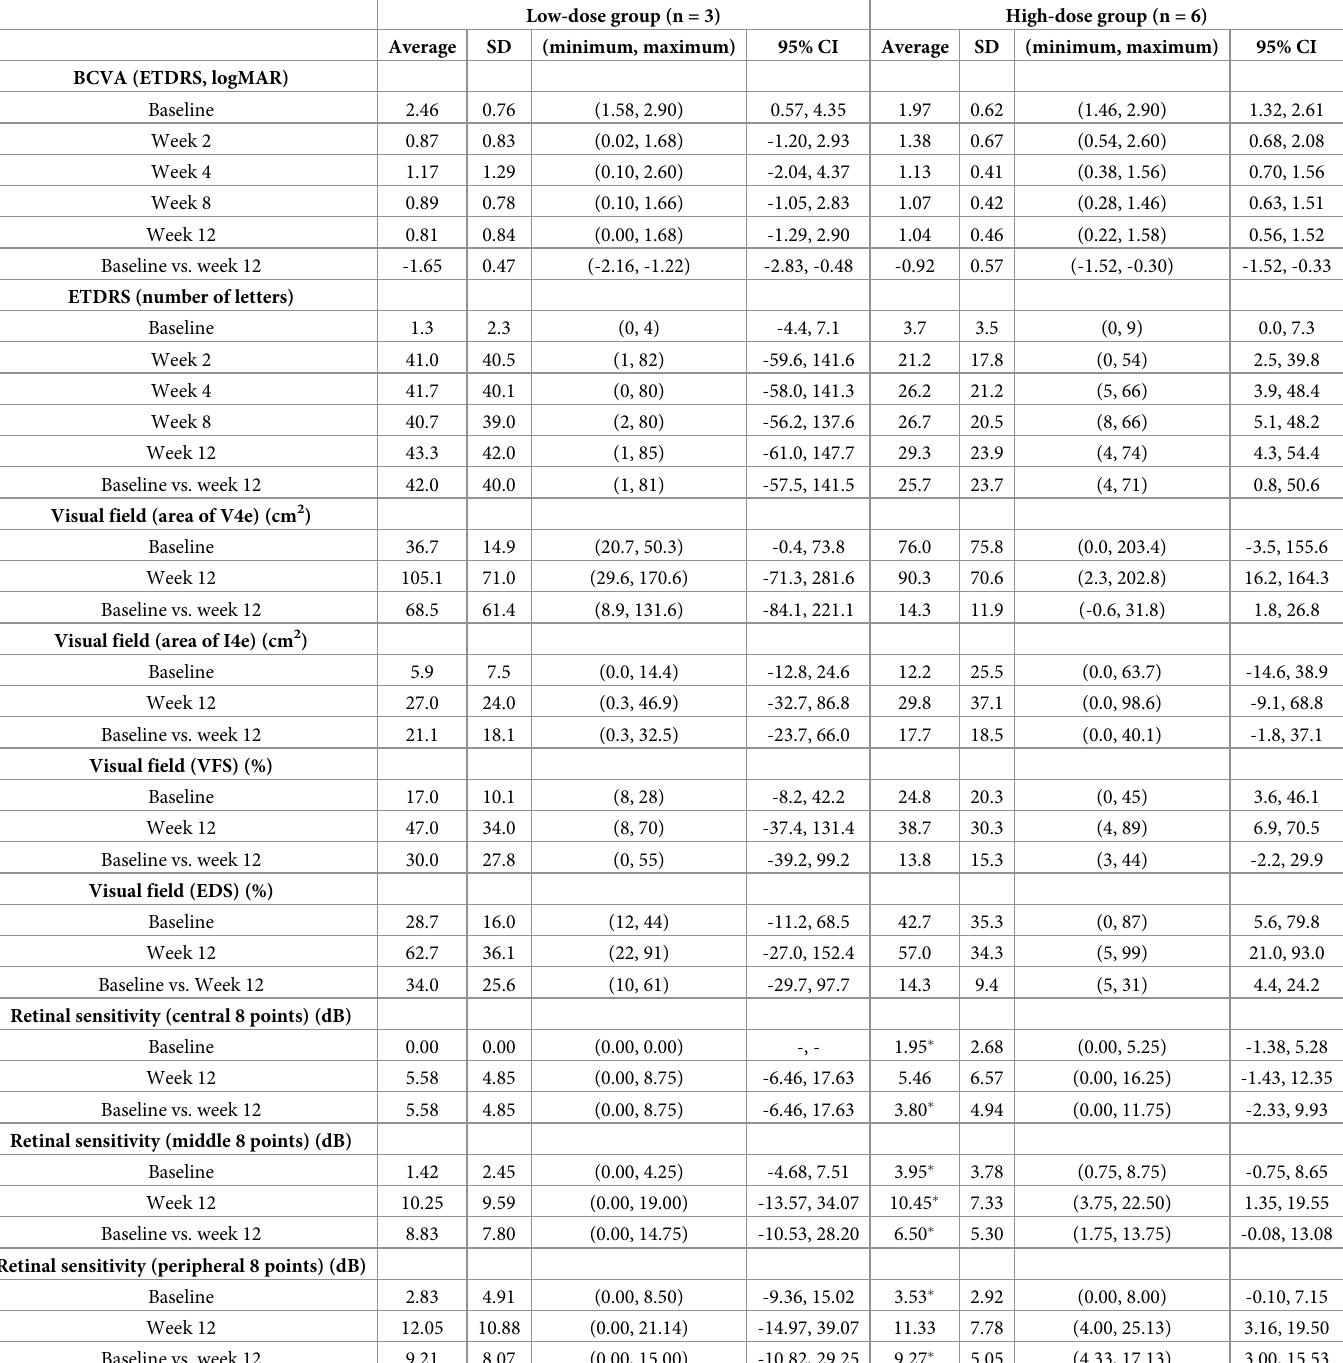
Table 6. Secondary outcomes related to visual